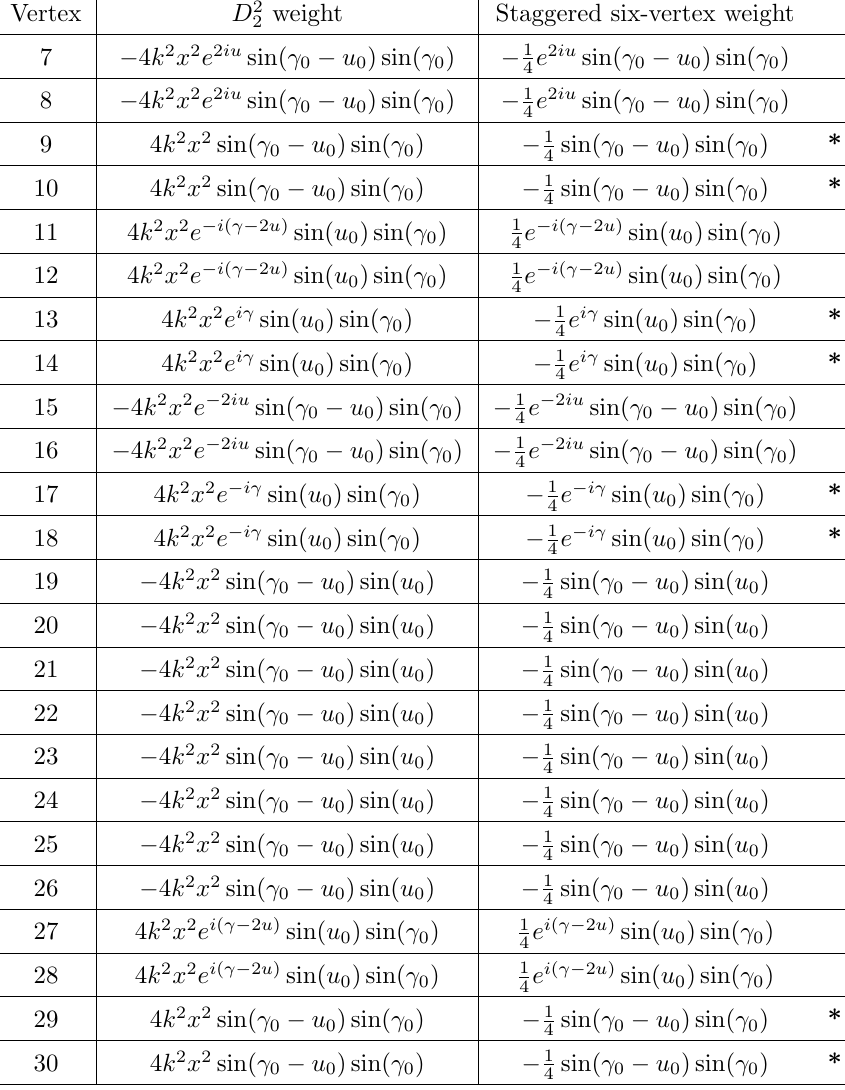
Table 2 . Correspondence between Boltzmann weights (continued). Vertices 7 to